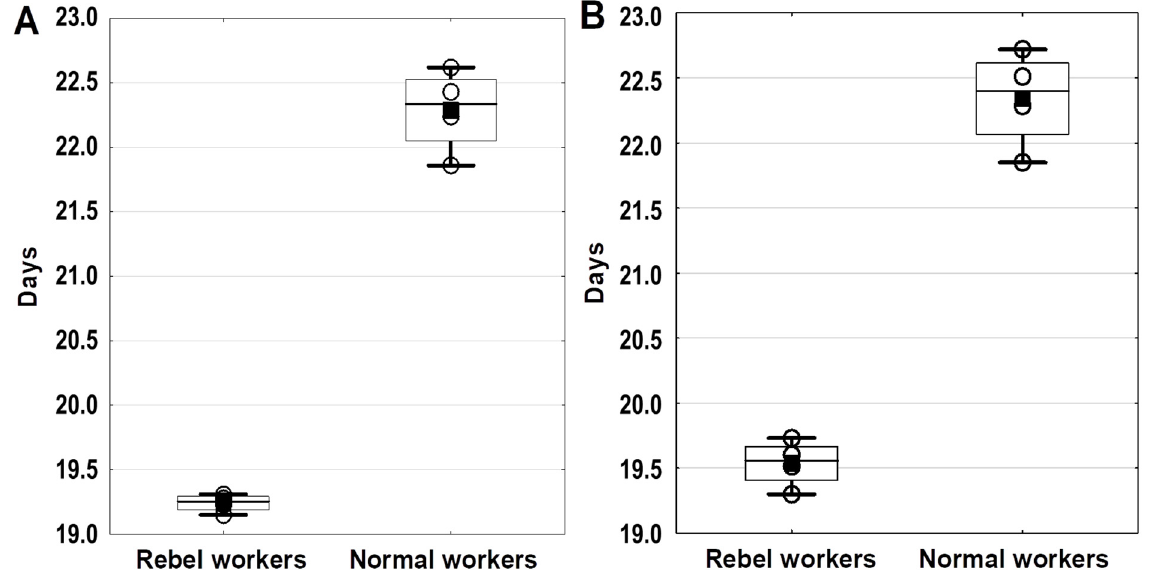
Figure 1. The total duration (days) of the preimaginal stages in the individual development of the first emerged workers ( A ) and the time necessary for 50% of the workers to emerge ( B ).